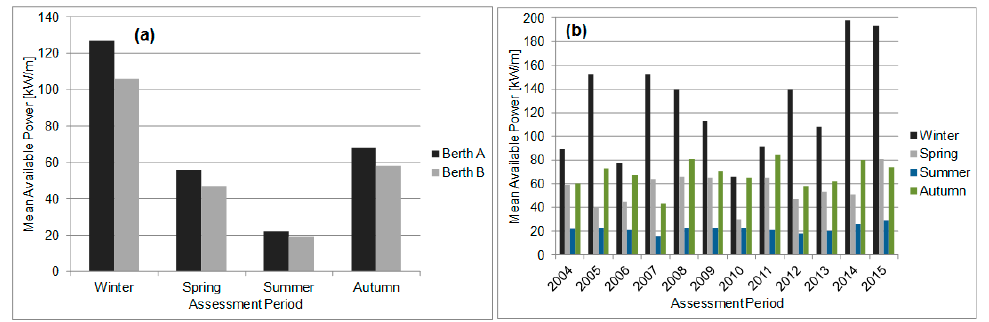
Figure 24. ( a ) Seasonal mean powers at BA and BB and ( b ) inter-annual comparison of seasonal mean P at BA.